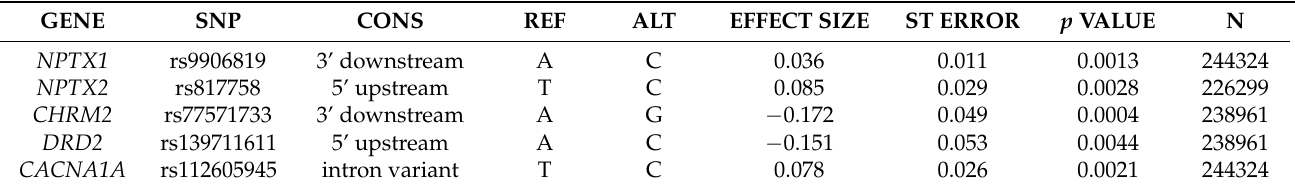
Table 5. Most significant SNPs in selected gene regions.